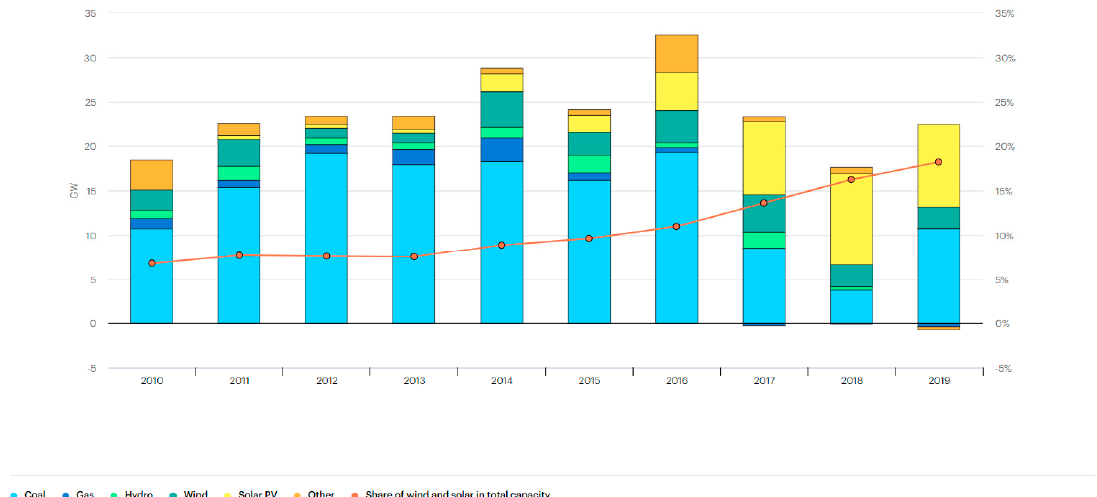
Figure 8. Annual power sector capacity additions in India, 2010–2019 [48].